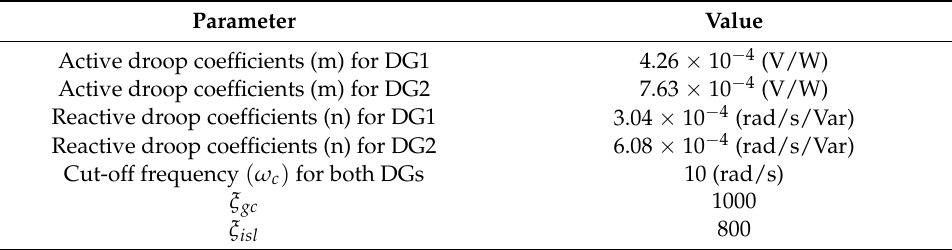
Table 2. Control